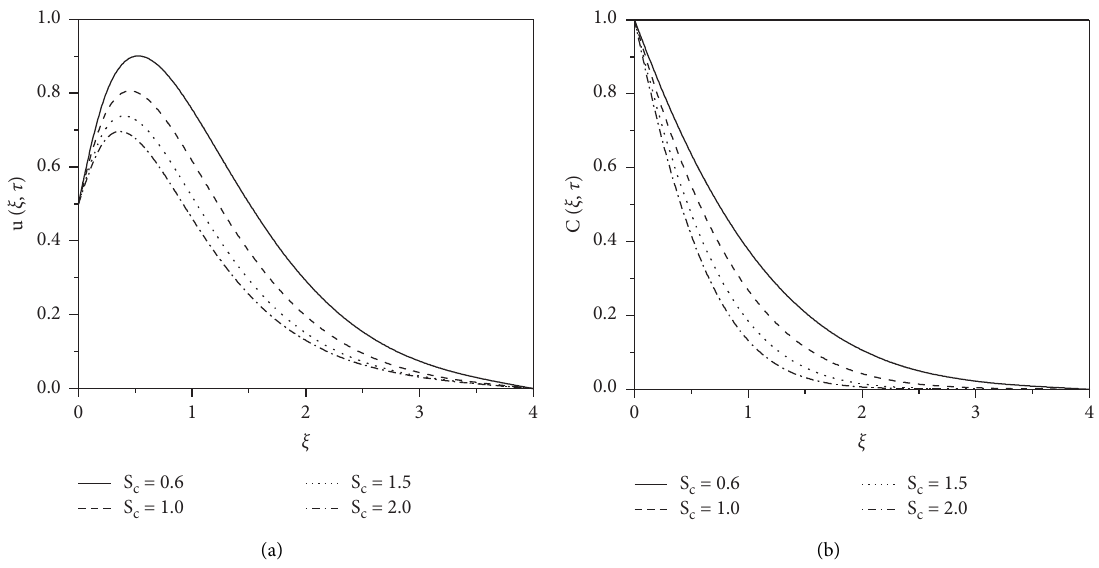
Figure 7: Variation of (a) velocity u ( ξ , τ ) and (b) concentration C ( ξ , τ ) against ξ for various values of S